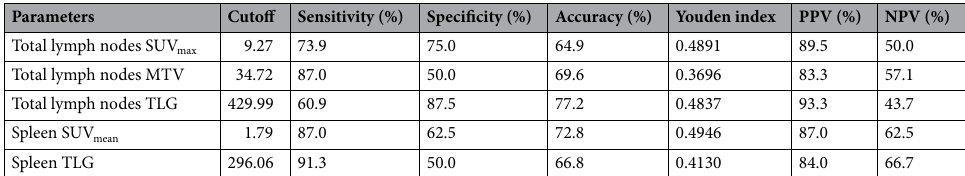
Table 2. Diagnostic performance of positron emission tomography/computed tomography for the severity of Kikuchi-Fujimoto disease. PPV, positive predictive value; NPV, negative predictive value; SUV max , maximum standardized uptake value; MTV, metabolic tumor volume; TLG, total lesion glycolysis; SUV mean , mean standardized uptake value